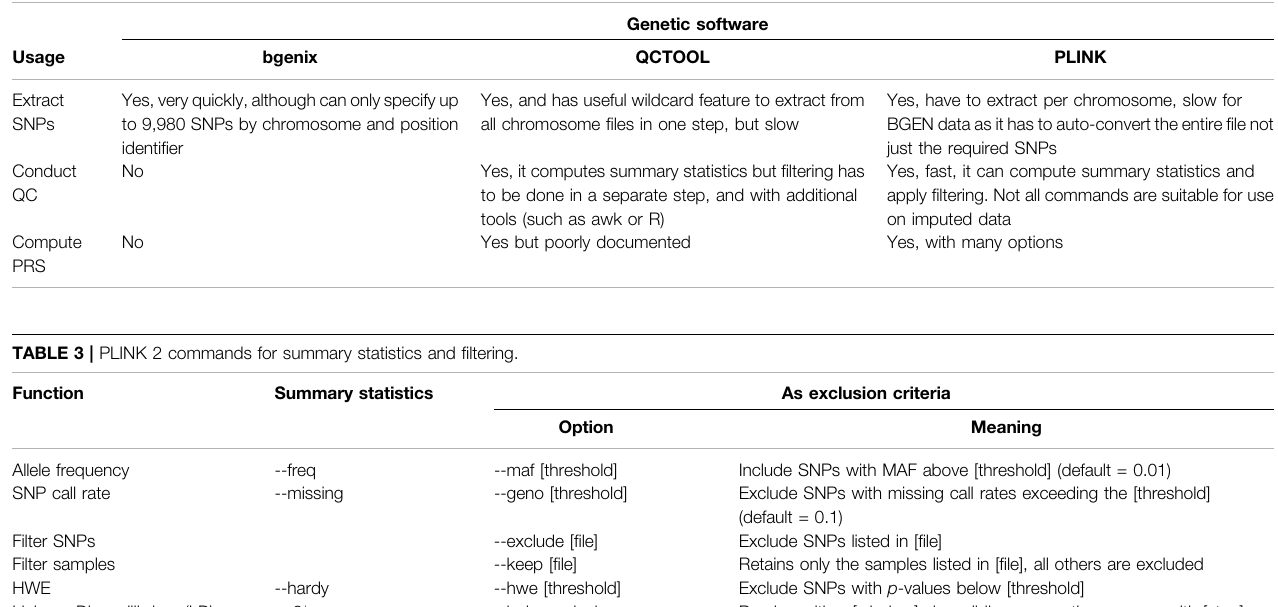
TABLE 2 | Comparison between genetic software for various usages.